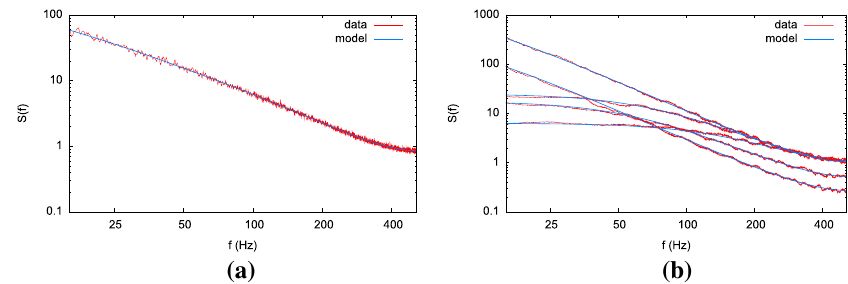
Fig. 70 Spectra for the locally-stationary AR ( 1 ) model. Panel a shows the smoothed spectrum computed using the full data set compared to the time average of the theoretical spectrum. Panel b shows smoothed spectra from the 1st, 8th, 16th, 24th and 32nd time segments compared to the theoretical S ( t ; f ) computed at the central time for each